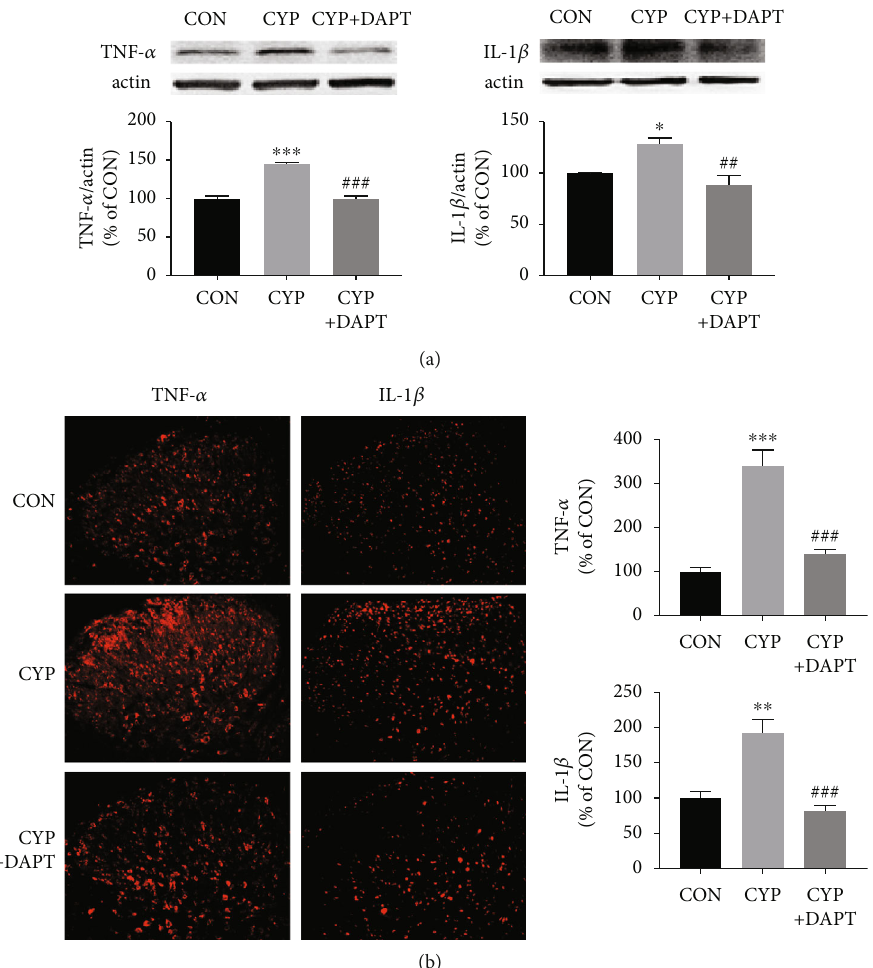
Figure 4: Inhibition of Notch1 signaling suppressed TNF- α and IL-1 β production in the SDH of CYP-induced cystitis model. (a) Western blotting analysis showed that intrathecal injection of DAPT signi fi cantly inhibited the production of the two critical proin fl ammatory cytokines, TNF- α and IL-1 β . (b) Immuno fl uorescence staining also showed that the production of TNF- α and IL-1 β was inhibited by intrathecal injection of DAPT. n = 5 per group. ∗ P < 0 : 05 , ∗∗ P < 0 : 01 , and ∗∗∗ P < 0 : 001 vs. CON group; ## P < 0 : 01 and ### P < 0 : 001 vs. CYP group. Data were analyzed by one-way ANOVA followed by the Tukey post hoc